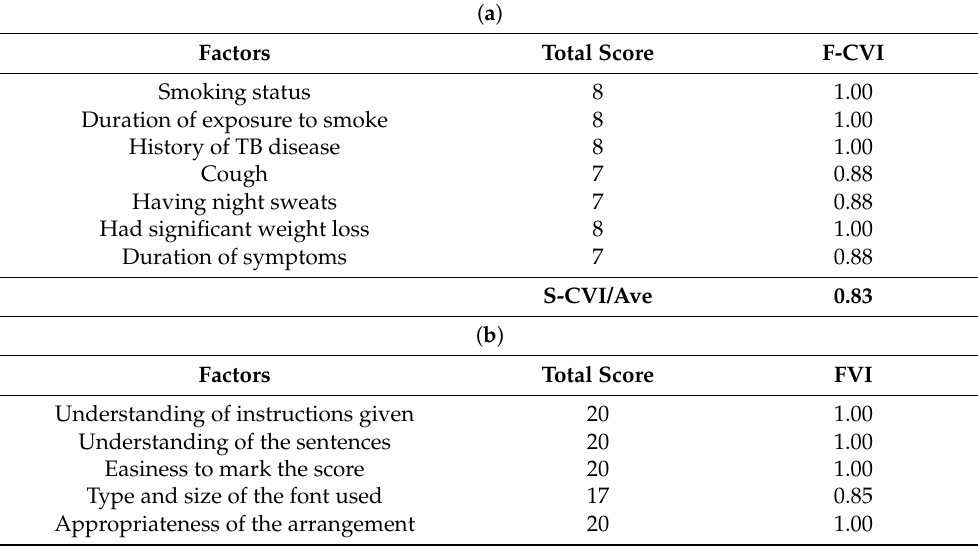
Table 4. ( a ): The factor-content validation index (F-CVI) for each factor and scale-level content validity index, averaging method (S-CVI/Ave) of the respondents (n = 8). ( b )The face validity index (FVI) for each factor (n =